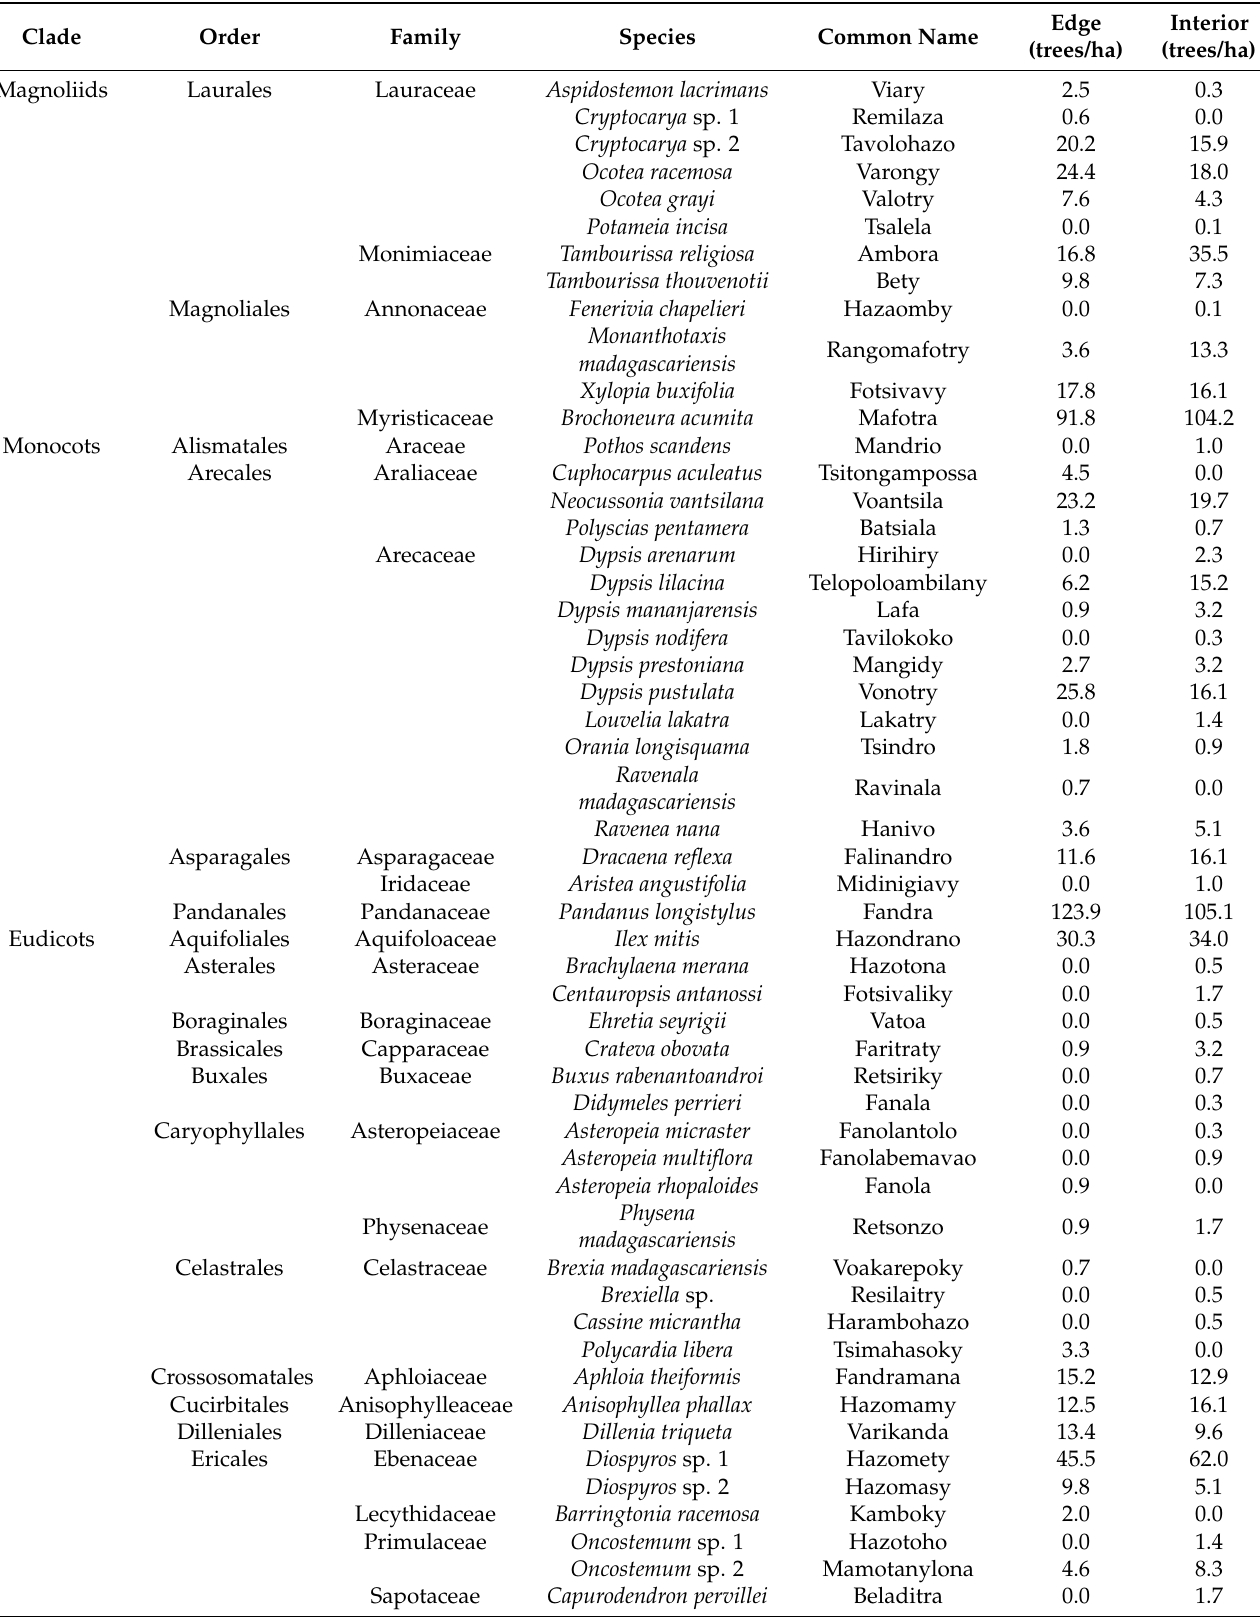
Table A2. Species present at the Ampasy forest with relative abundance in edge and interior based on 33 vegetation